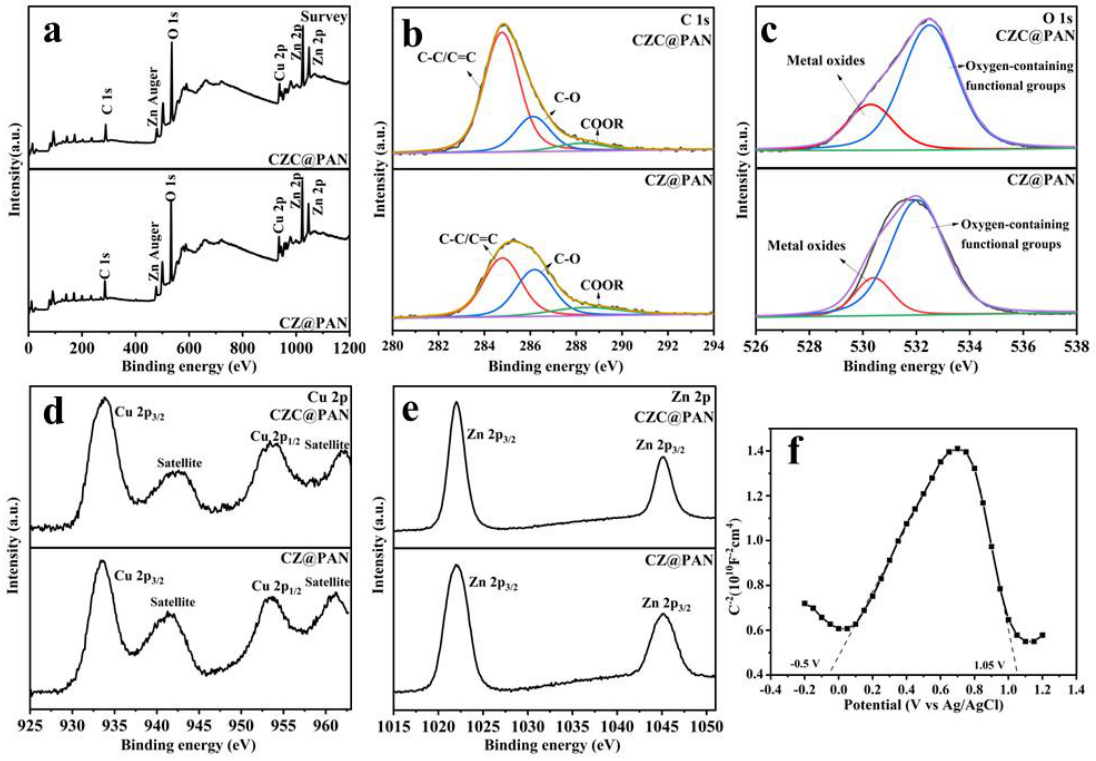
Figure 2. XPS spectra of samples: survey ( a ), C 1s ( b ), O 1s ( c ), Cu 2p ( d ), and Zn 2p ( e ); Mott-Schottky curve of CZC@PAN ( f ).